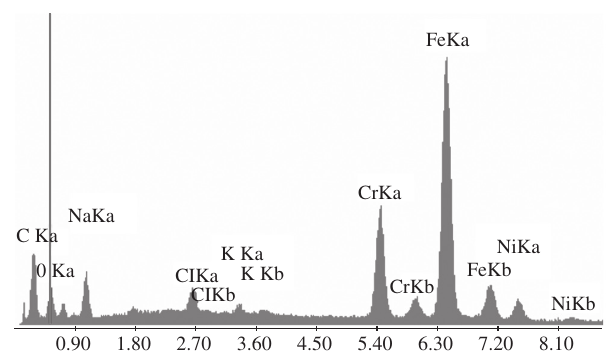
Figure 5. Scanning electronic microscopy (SEM) a) Surface analysis of AISI 304 steel heat treated at 300 °C; and b) Enlarged detail of the Figure